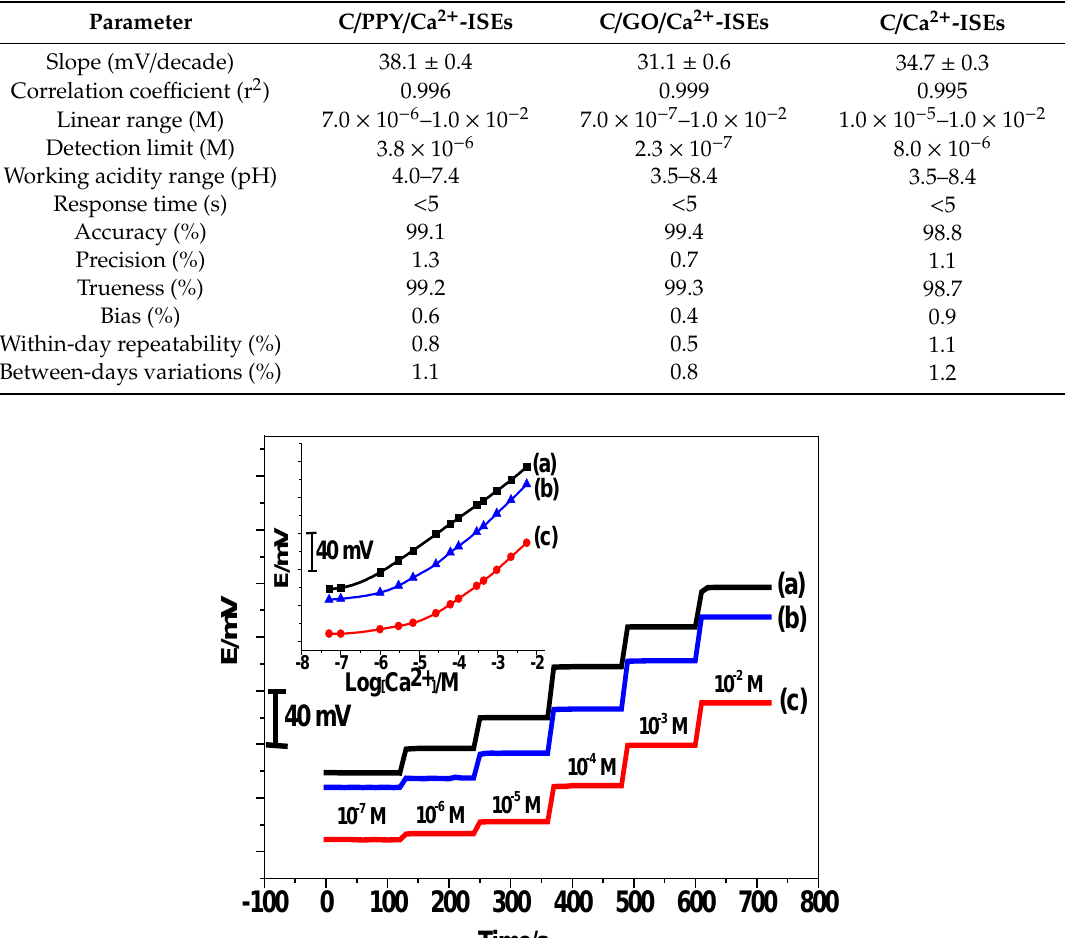
Table 1. Potentiometric characteristics of SPC/Ca 2+ -ISEs in 50 mM, tris buffer solution ( pH = 5) .